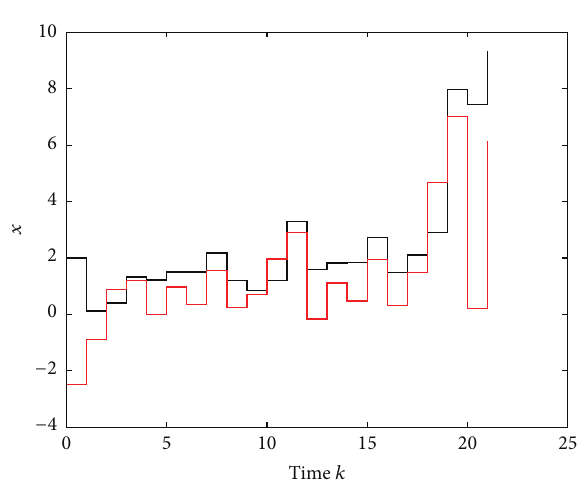
Figure 1: 𝑟 𝑘 of jump rates.